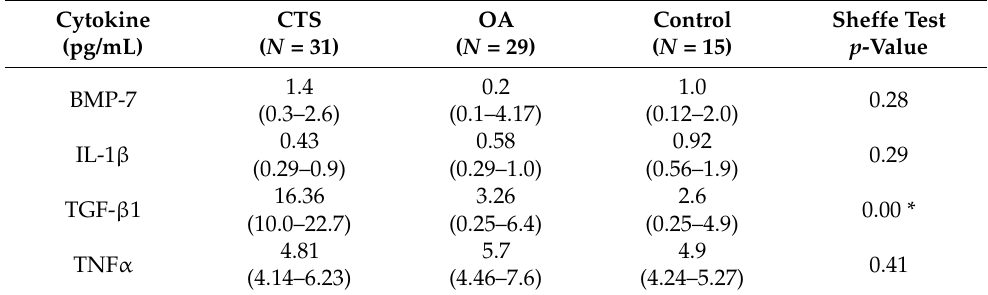
Table 2. Serum levels of inflammatory and fibrotic cytokines in CTS and OA groups of patients and healthy controls.